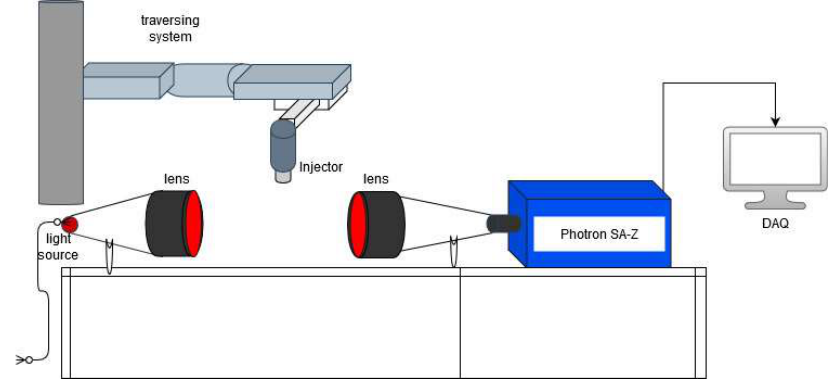
Figure 2. Schematic of the shadowgraph setup for the gas flow study (in-flow).